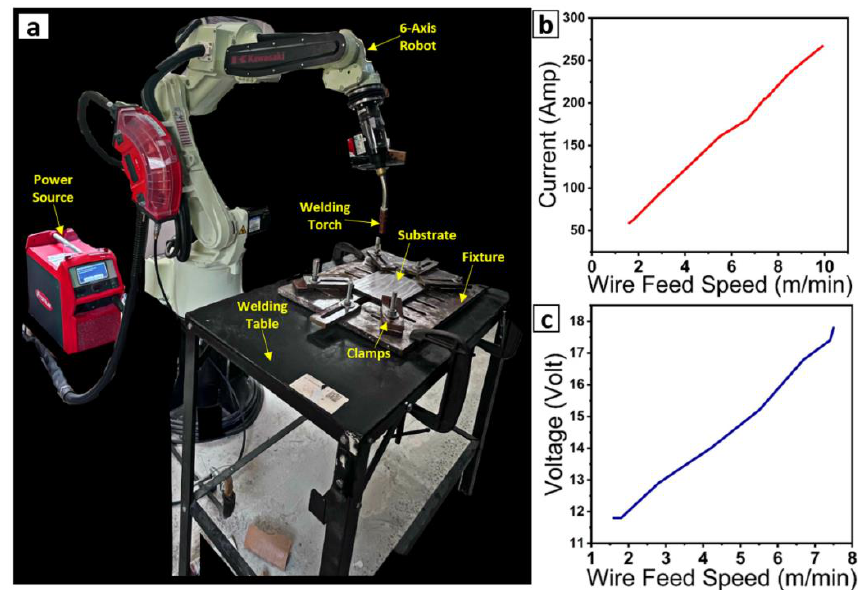
Figure 2. ( a ) The set-up of the WAAM process utilized to fabricate the thick walls out of SS410 material, the variation of ( b ) current and ( c ) voltage with respect to the WFS.